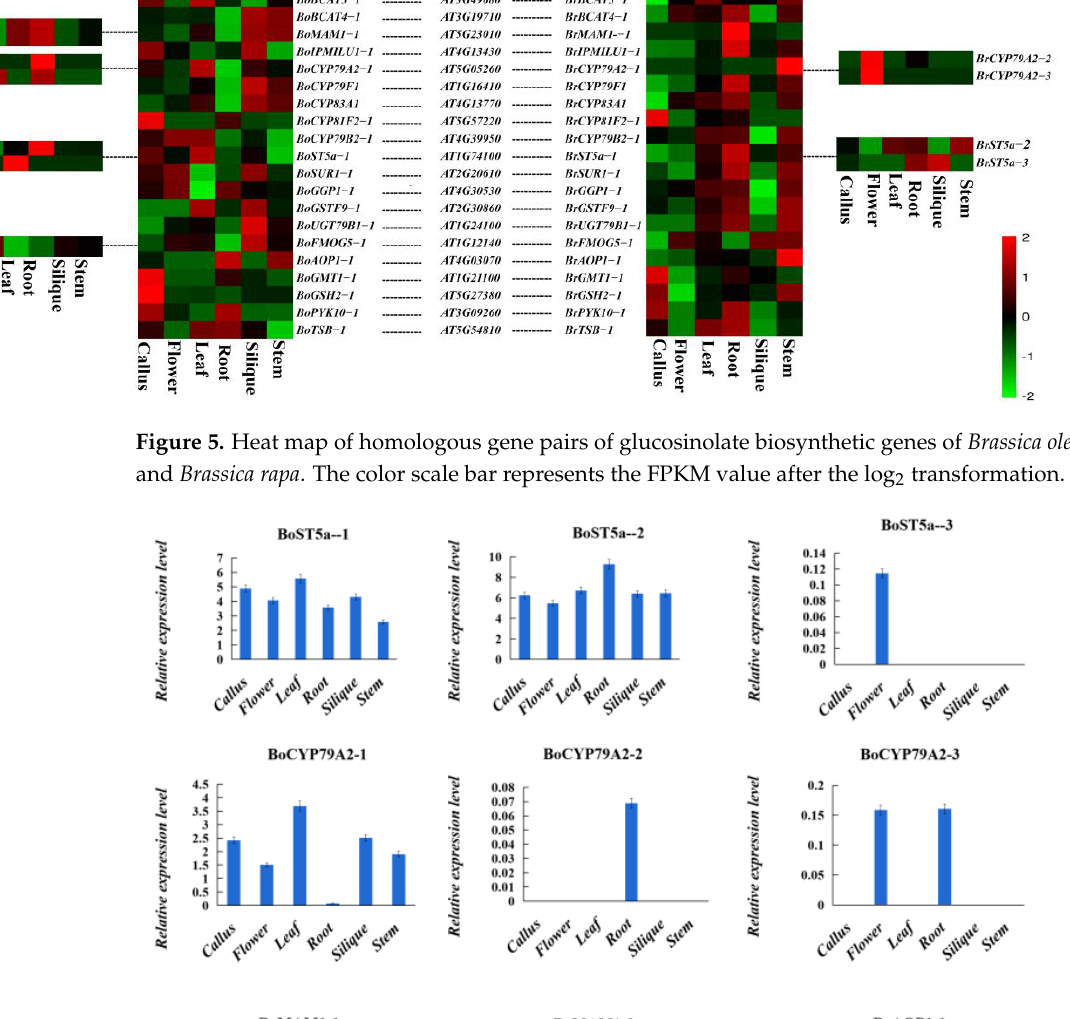
Figure 5. Heat map of homologous gene pairs of glucosinolate biosynthetic genes of B rassica oleracea and B rassica rapa . The color scale bar represents the FPKM value after the log 2 transformation.